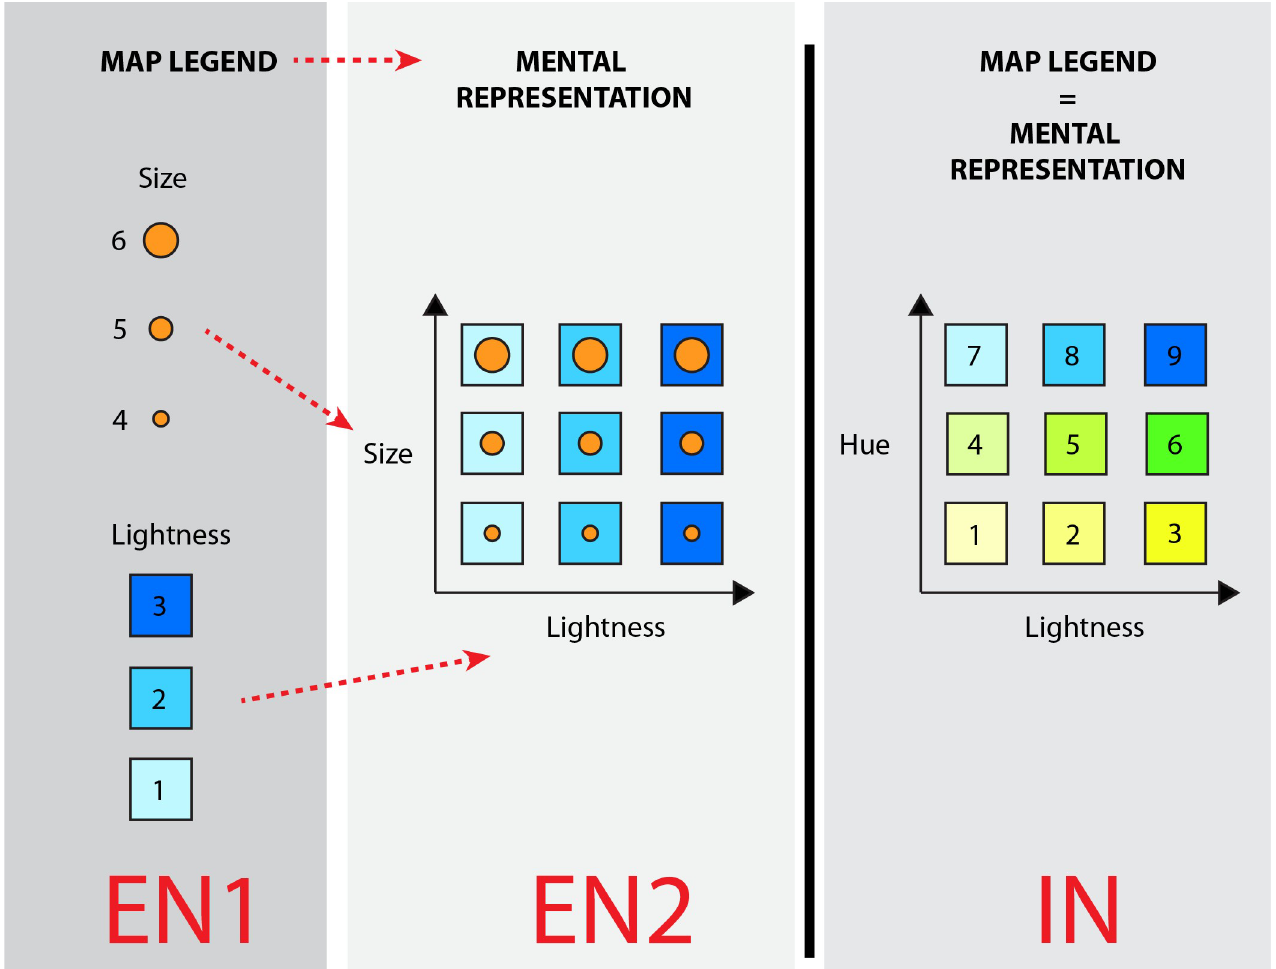
Fig 1. Examples of extrinsic and intrinsic bivariate encoding of geographic variables. EN1: extrinsic (separable) encoding of variables according to size and color lightness; EN2: mental representation of extrinsic visualization (all the possibilities); IN: intrinsic (inseparable) encoding of variables according to hue and